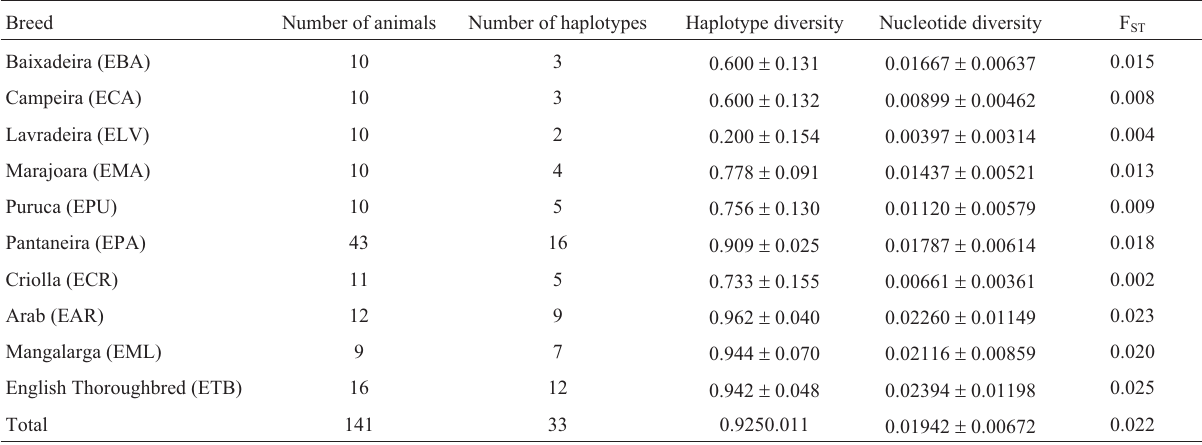
Table 1 - Estimated haplotype and nucleotide diversity from the d-loop region of mtDNA, in locally adapted and specialized Brazilian horse breeds. Breed Number of animals Number of haplotypes Haplotype diversity Nucleotide